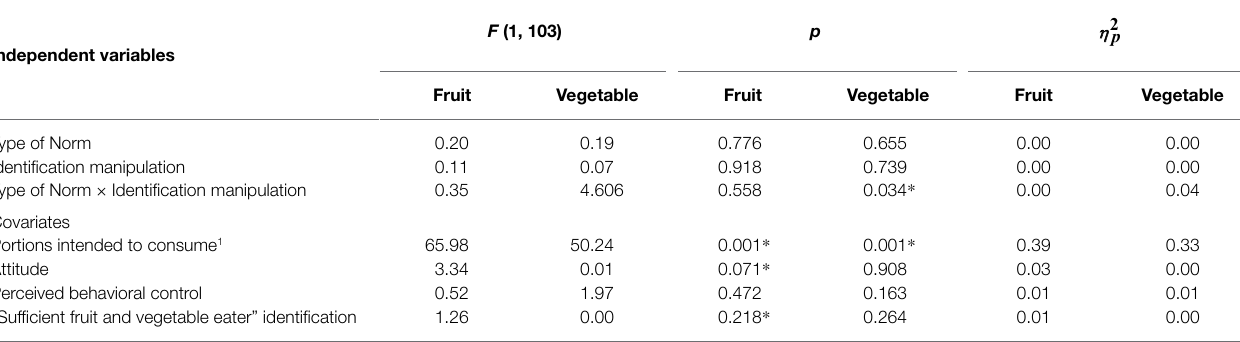
TABLE 7 | ANCOVA table for fruit and vegetable intake at two-day follow-up (Part 2).